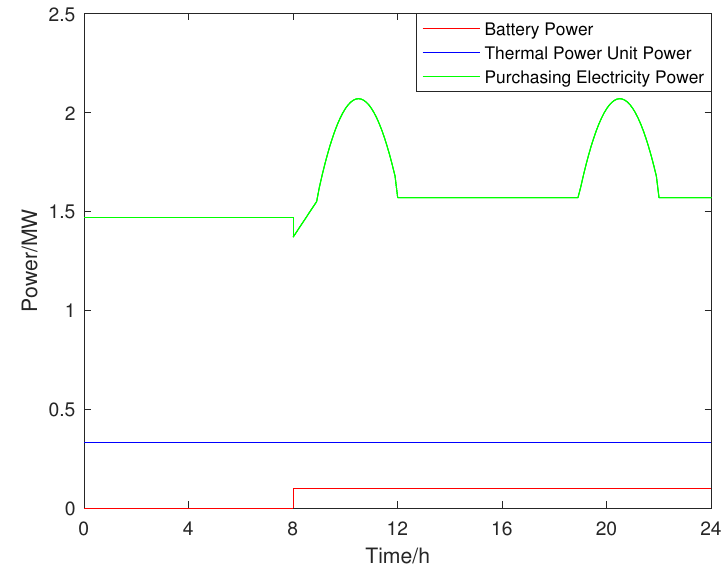
Figure 11. Power of each equipment at